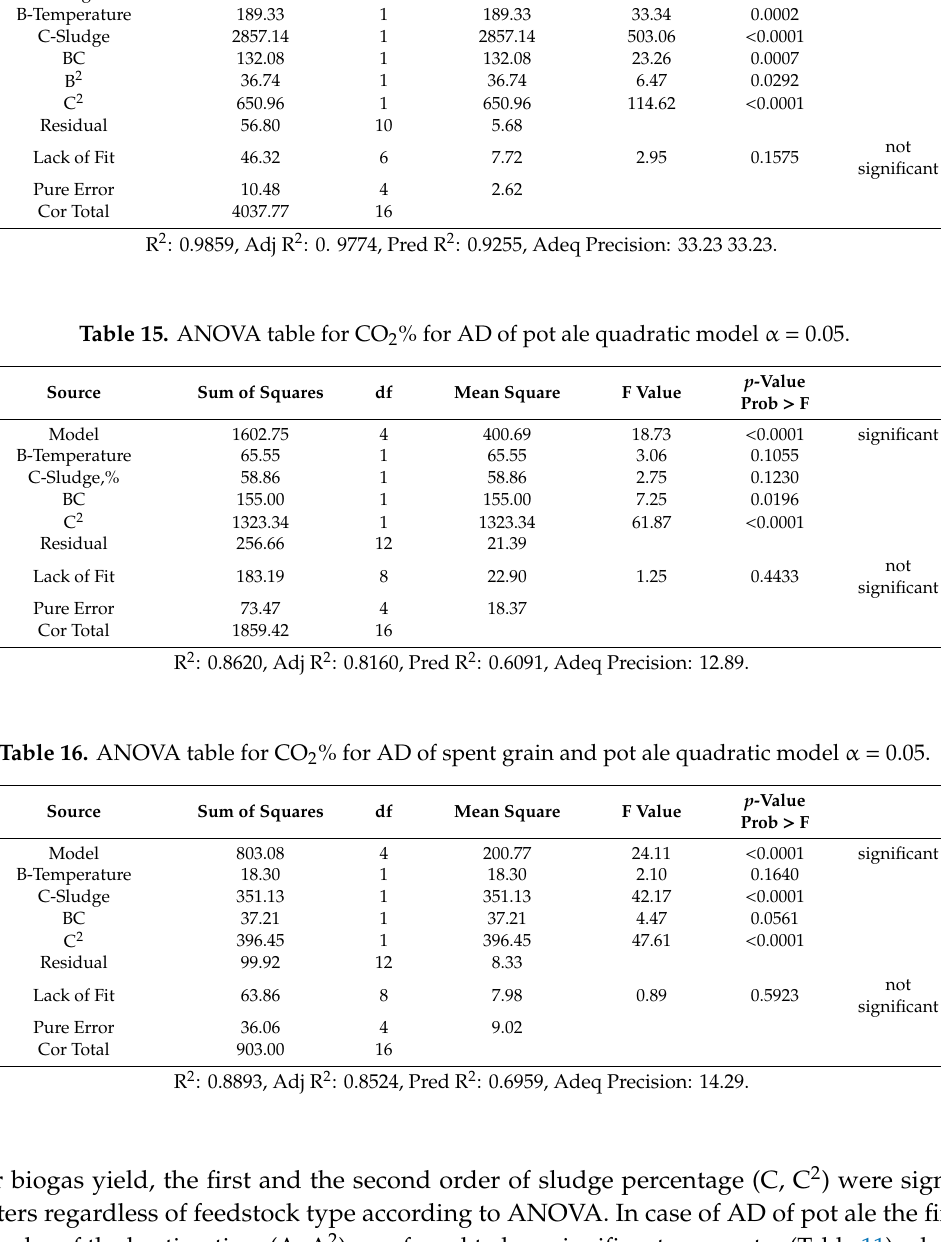
Table 14. ANOVA table for CH 4 % for AD of spent grain and pot ale quadratic model α = 0.05. Source Sum of Squares Model